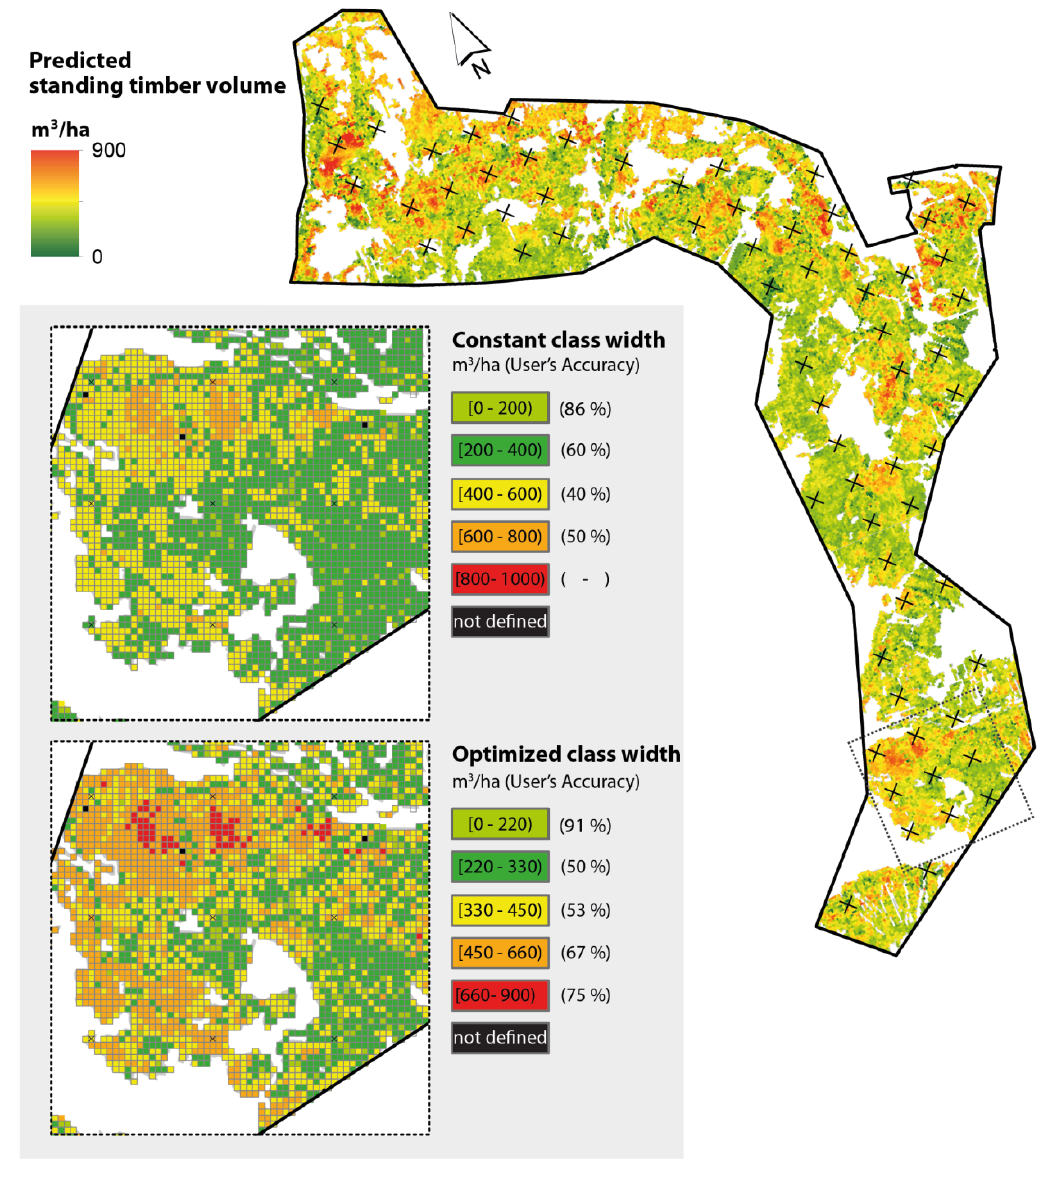
Figure 7. Volume map with model-predictions on a continuous scale for the entire study area covering 2000 hectares of forest with a spatial resolution of 25 meters; the subareas show the classified volume map using a constant class width of 200 m 3 ha − 1 (upper) and locally-optimized class widths for five classes